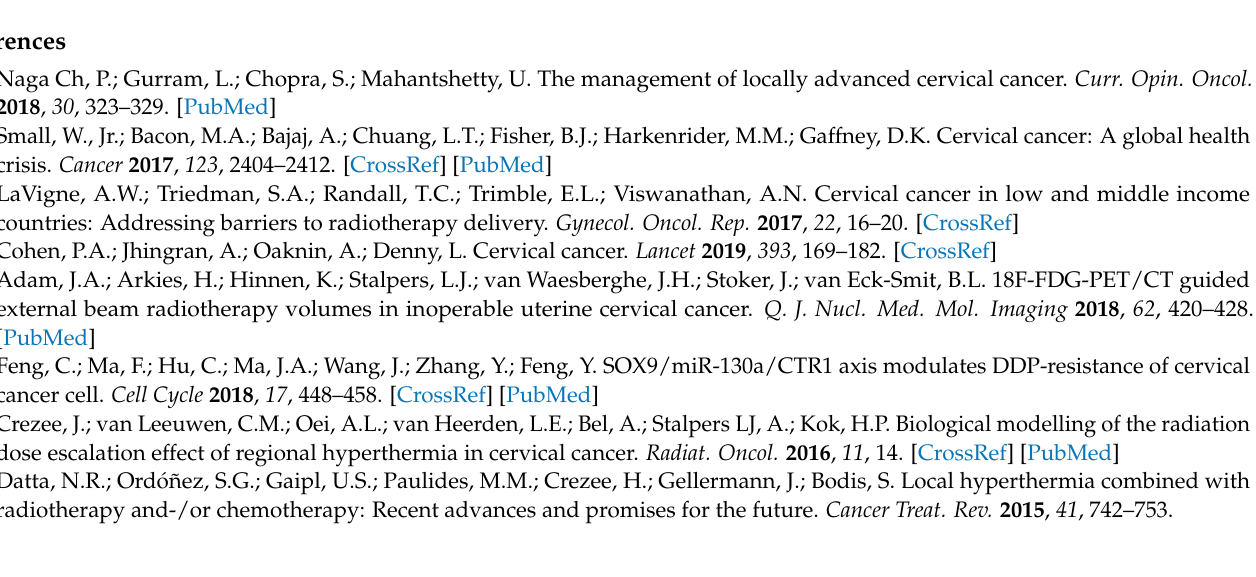
Figure S2: In vitro analysis of γ -H2AX foci per nucleus in HeLa cells, Figure S3: In vitro analysis of γ -H2AX foci per nucleus in CaSki cells, In vitro analysis of γ -H2AX foci per nucleus in C33A cells, Figure S4: In vitro analysis of γ -H2AX foci per nucleus in C33A cells, Table S1: Statistical analysis (Independent samples t -Test) of the colony formation, Table S2: Surviving fractions (SF) and plating efficiency (PE), Table S3: Statistical analysis (Mann-Whitney U test) of the γ -H2AX foci formation, Table S4: Statistical analysis (Independent samples t -Test) of Annexin V positive cells, YoYo3 positive cells and normalized confluence. All authors have read and agreed to the published version of the